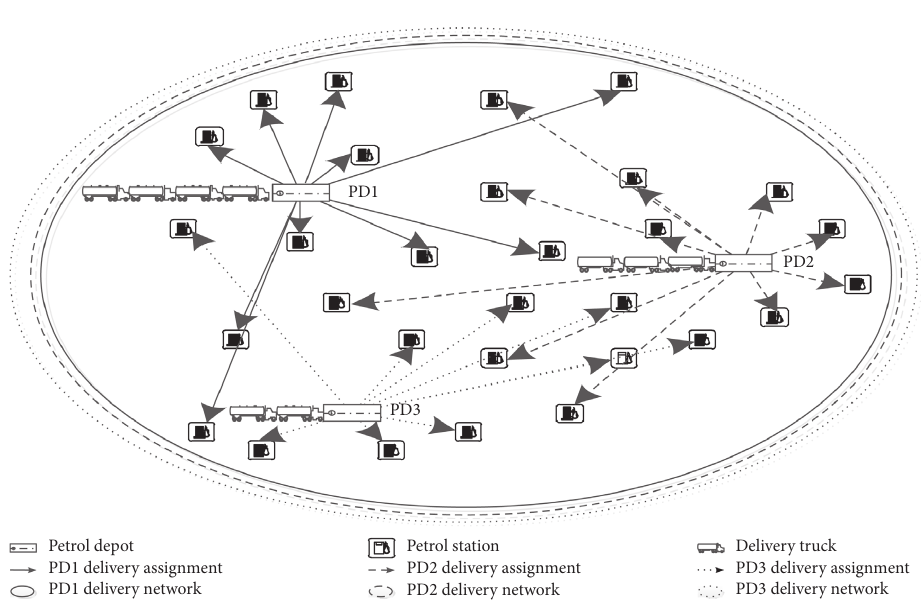
Figure 1: Noncooperative petrol distribution